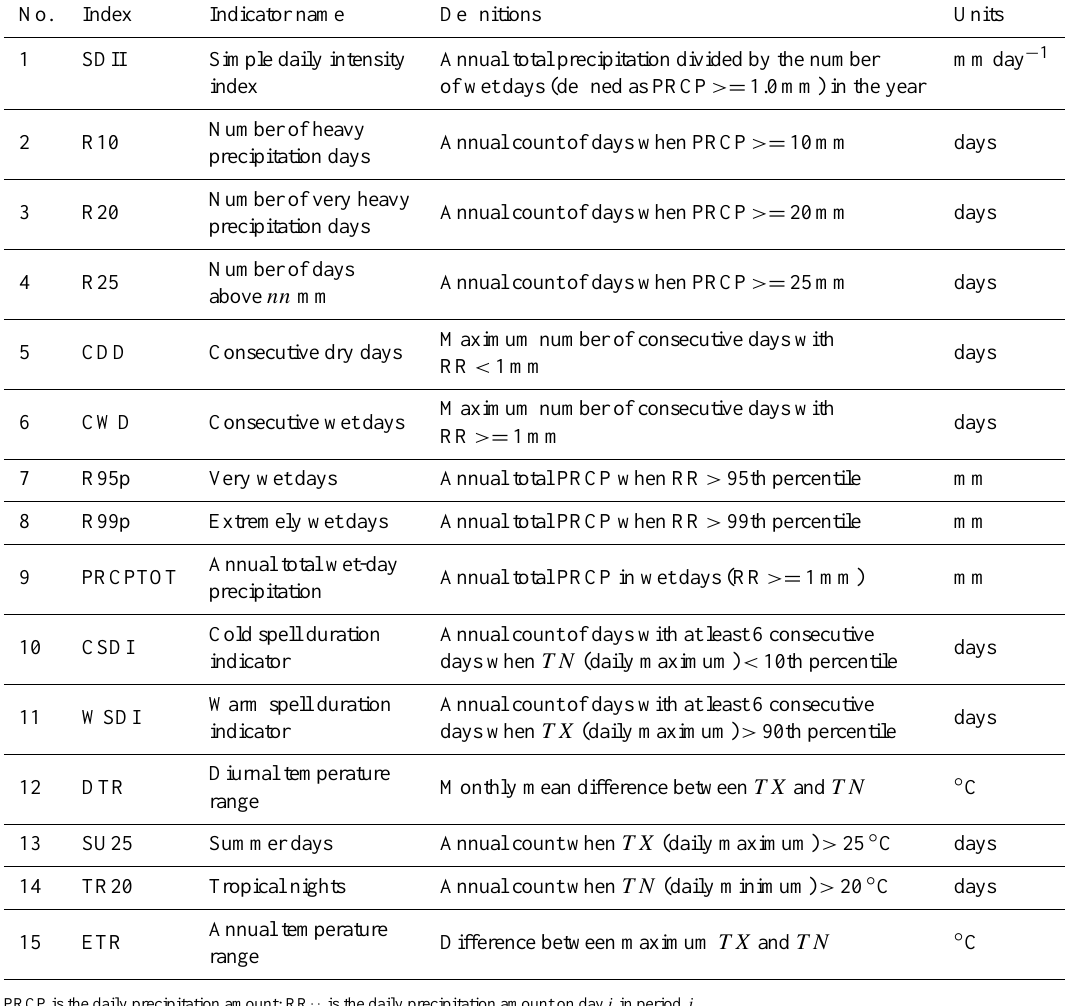
Table 1. List of extreme precipitation and temperature